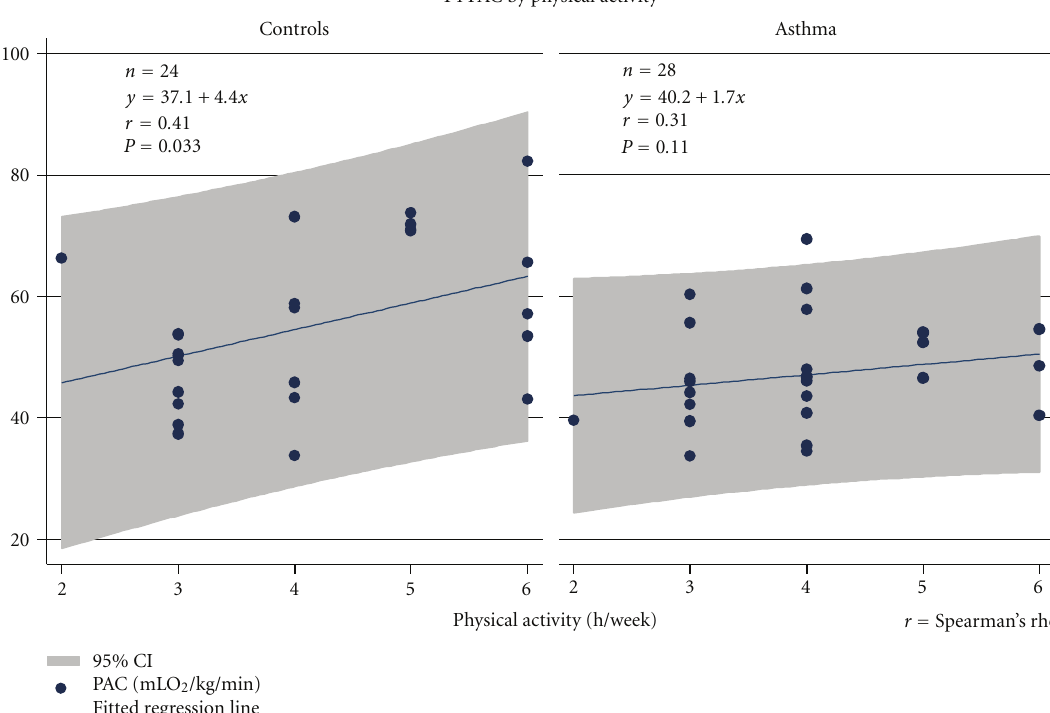
Figure 4: T4 associations between PAC (mLO 2 /min/kg) and physical activity (h/week) in asthmatics and